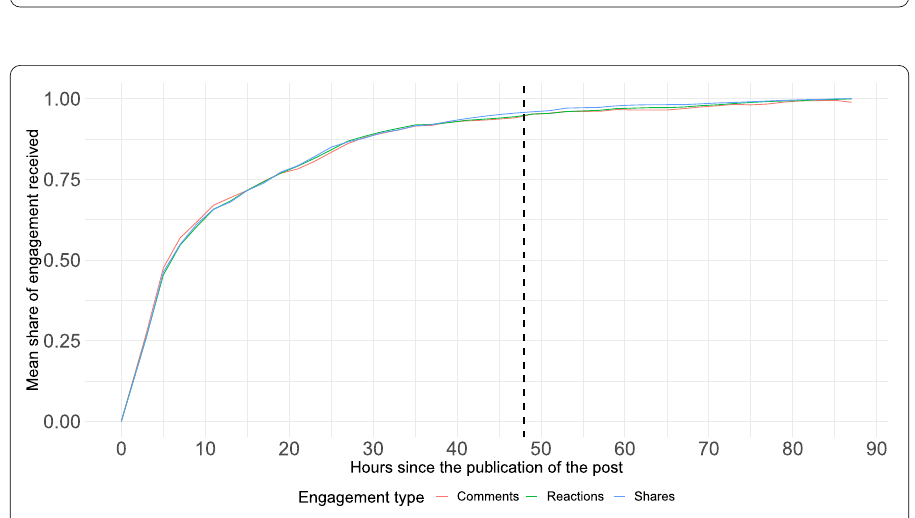
Figure 2 Engagement evolution after the publication of a post. The vertical line represents the 48 hours mark